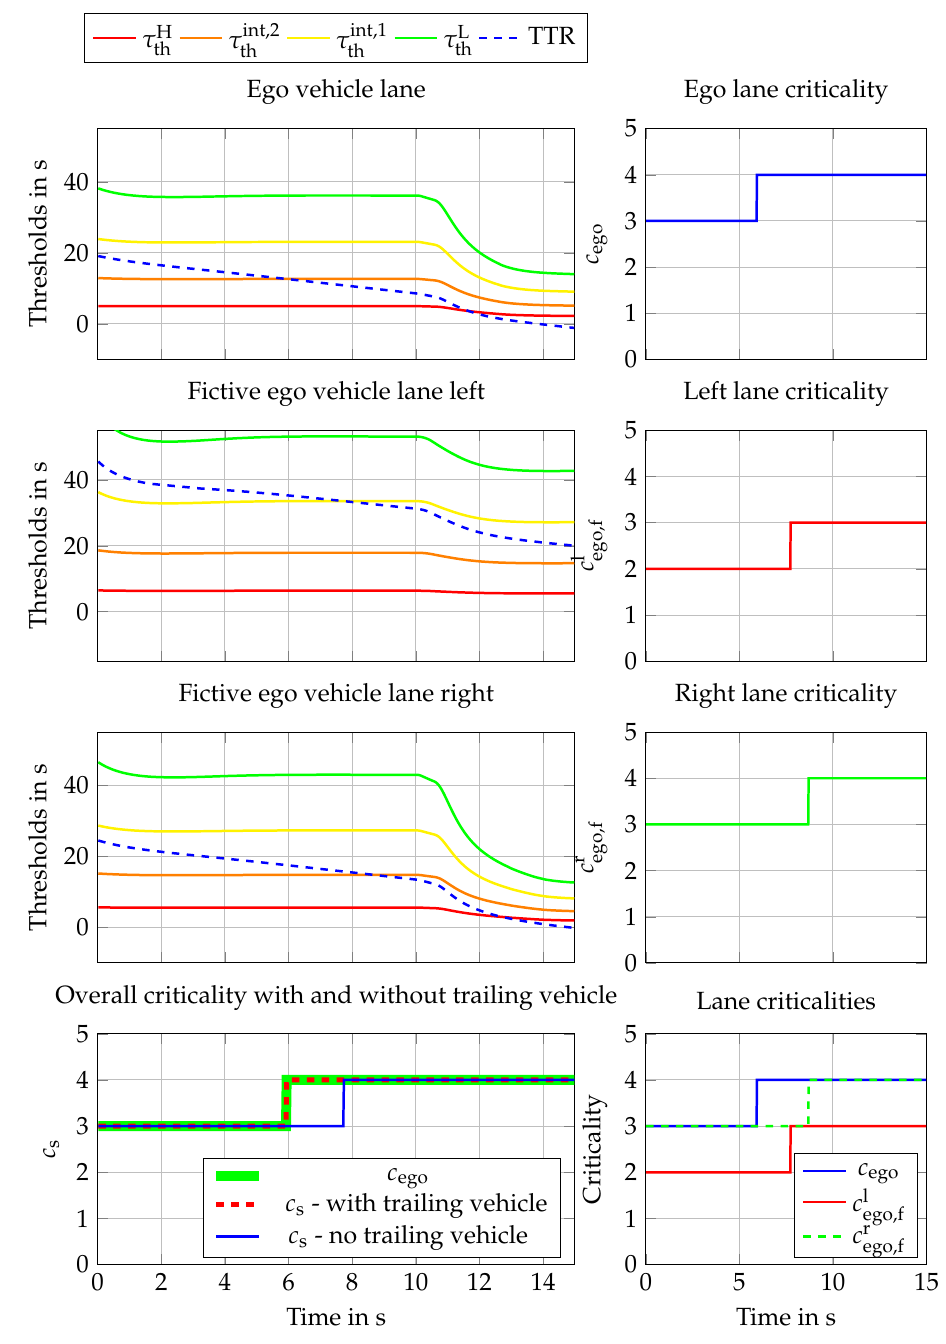
Figure 7. Criticality assessment results for the two introduced